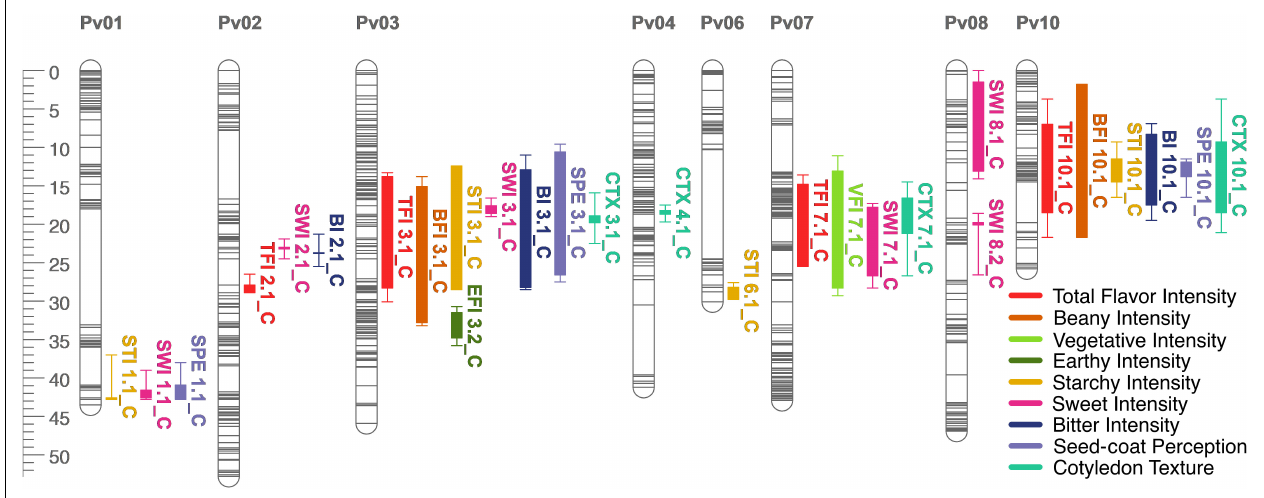
FIGURE 7 | QTL map for total flavor intensity (TFI), beany intensity (BFI), vegetative intensity (VFI), earthy intensity (EFI), starchy intensity (STI), sweet intensity (SWI), bitter intensity (BI), seed-coat perception (SPE), and cotyledon texture (CTX) in the RIL population. Size is in cM. All QTL were detected in both years combined.